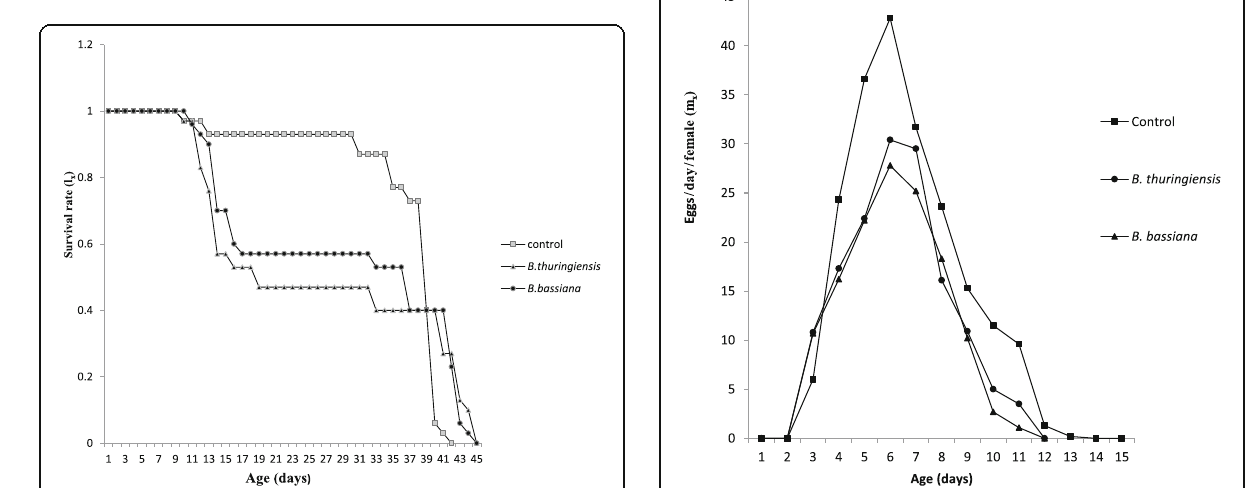
Fig. 2 Fecundity ( m x ) of T. absoluta treated as second instar larvae by LC 50 values of B. thuringiensis or B.